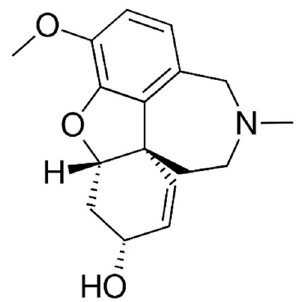
Figure 2. Molecular structure of galantamine.